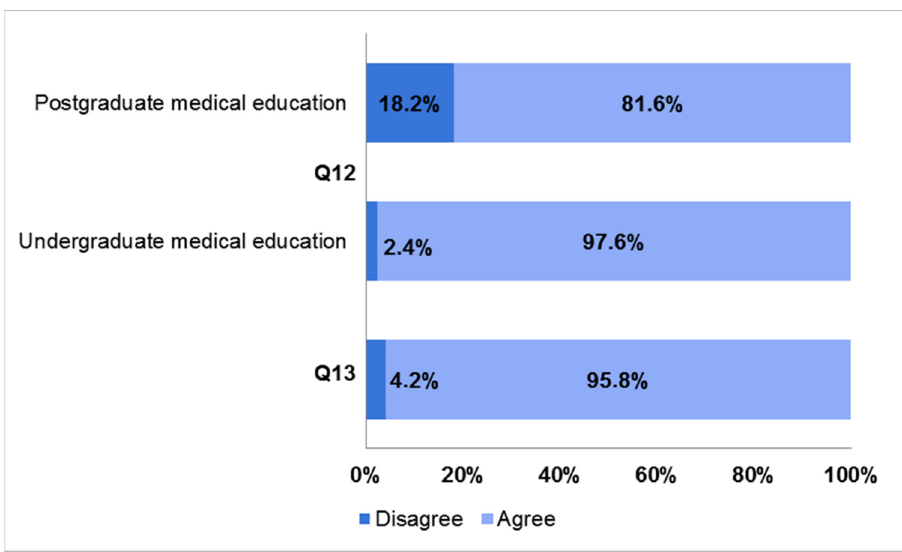
Figure 6. Bar charts showing responses to questions 12 and 13 of the survey. Q12: “Cadaver dissection is an invaluable and necessary learning tool in undergraduate/postgraduate medical education”. Q13: “Cadaver dissection is a powerful tool in positively shaping professional and ethical values like compassion, empathy and respect toward patients”.